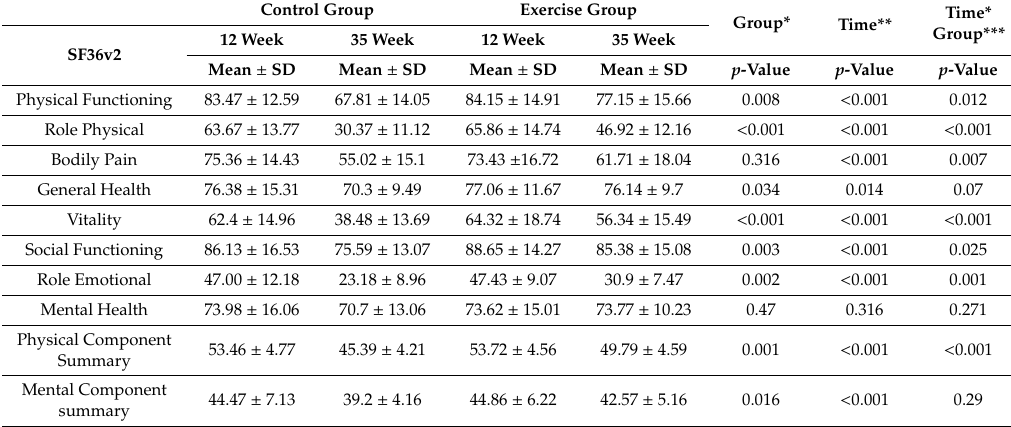
Table 3. Health-related quality of life during